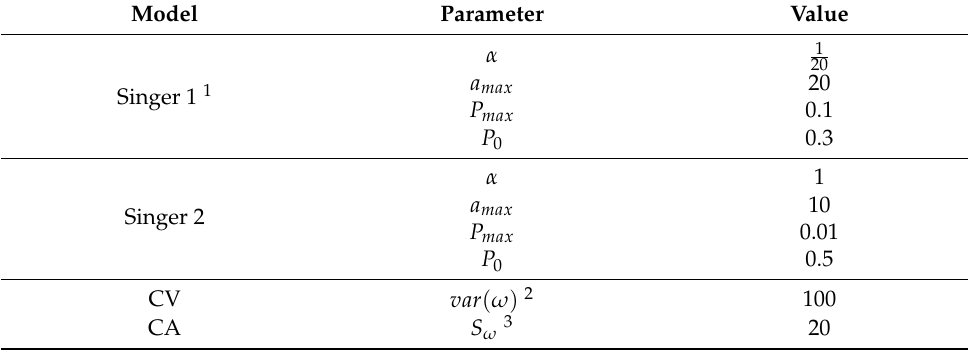
Table 2. The detailed information of the used